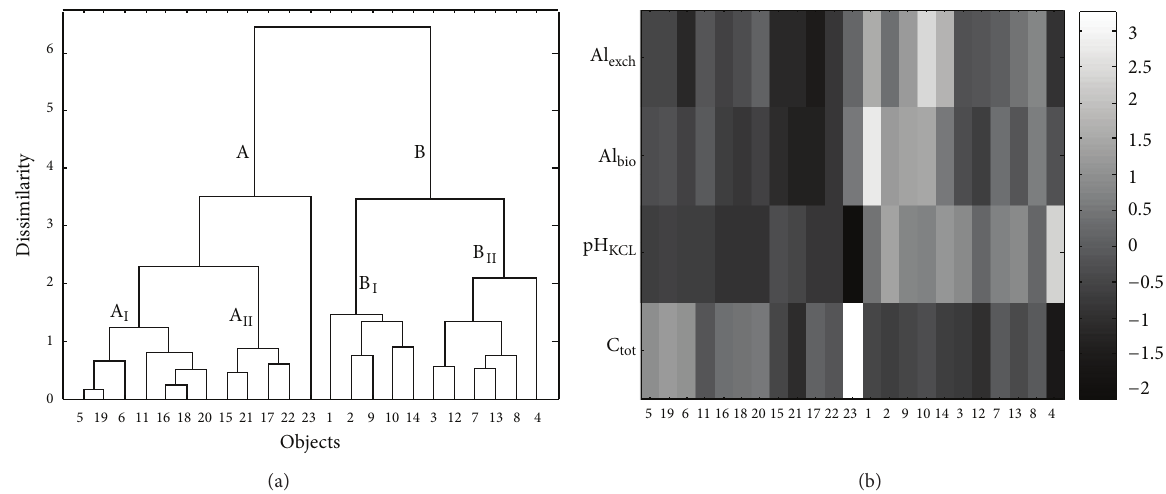
Figure 4: Dendrogram of samples with visual complement in the space of four parameters (pH aluminium content Al